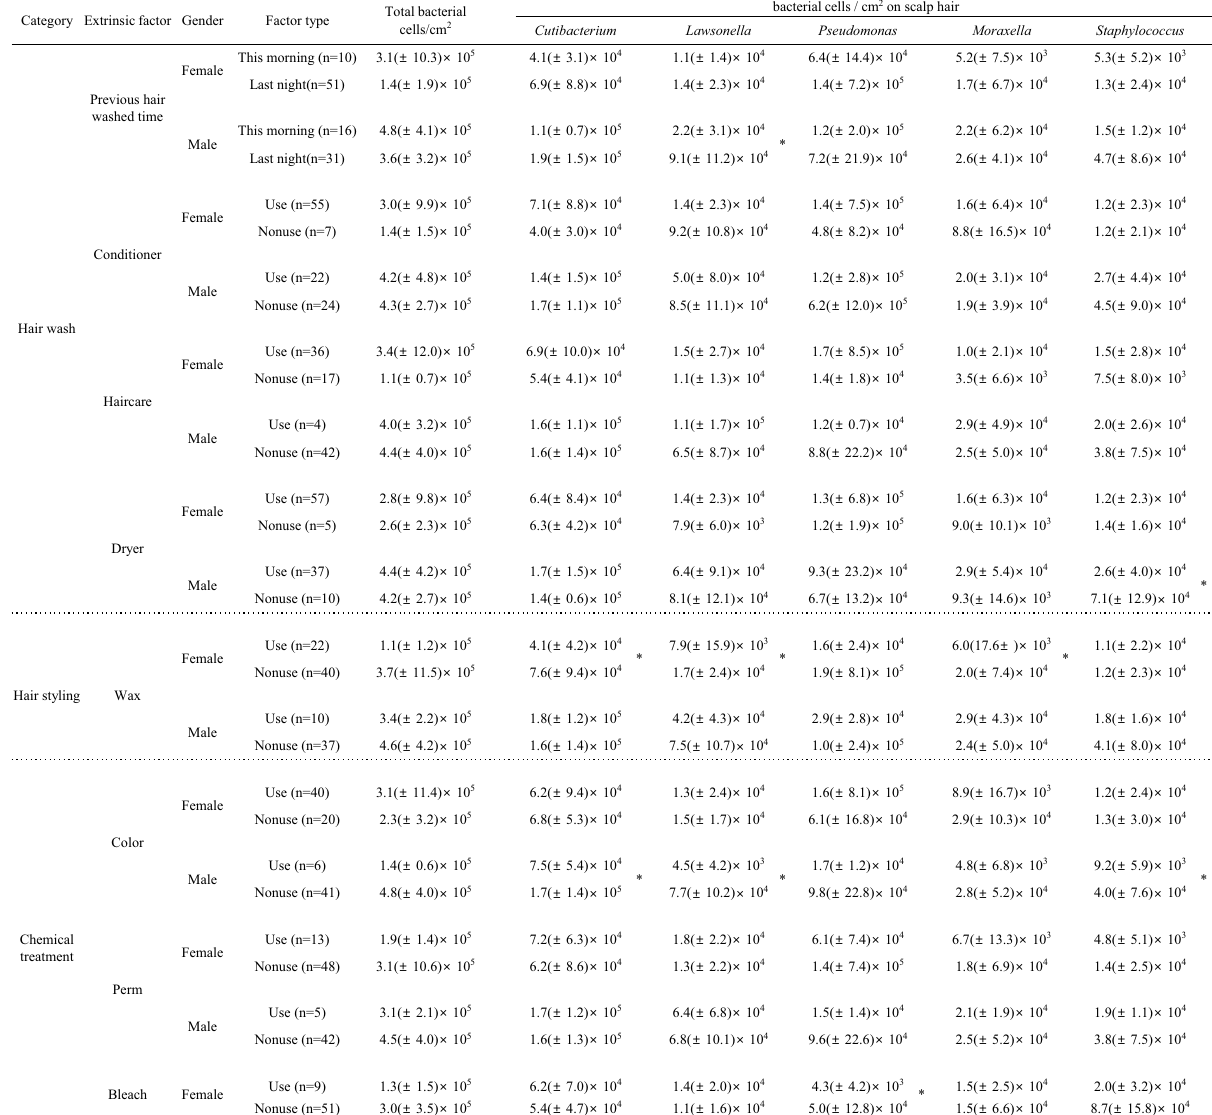
Table 4. Absolute number of major the bacterial genera at each comparative category and each gender. ** and * indicate significantly high and low numbers among extrinsic factors,